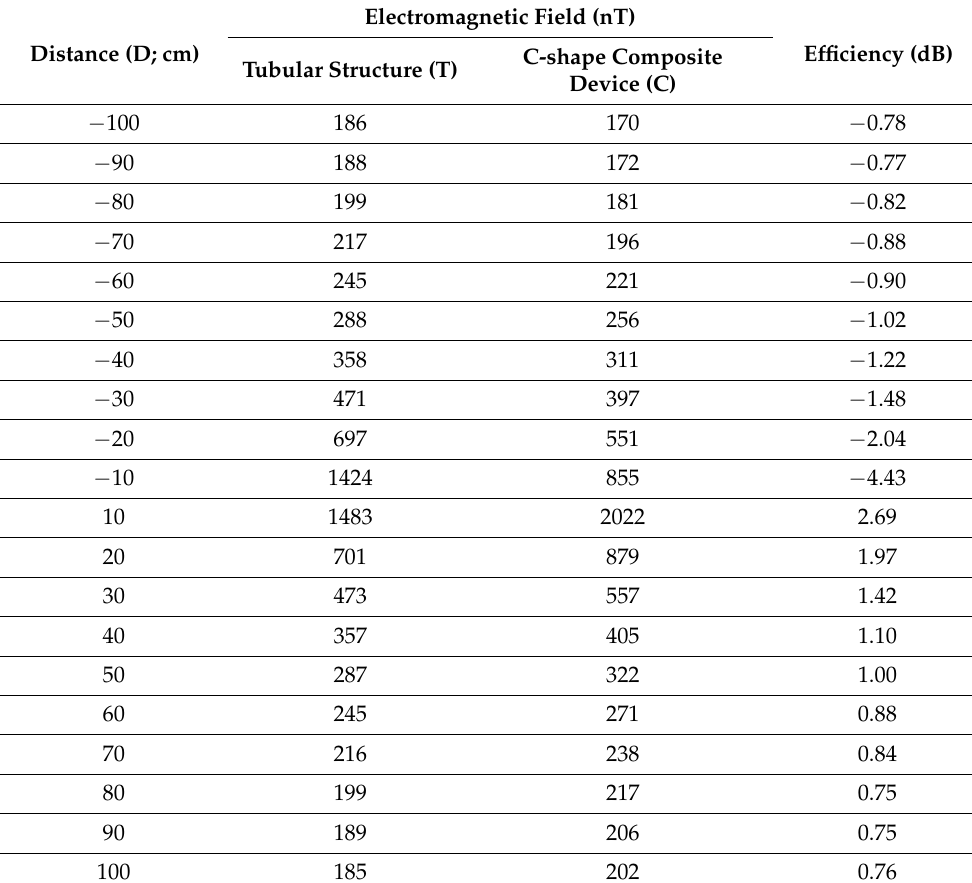
Table 1. Simulation data of electromagnetic